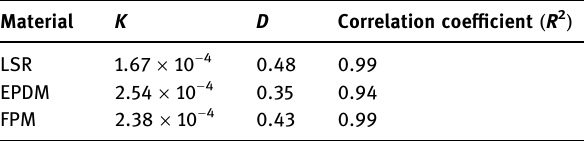
Table 2: Rubber material parameters